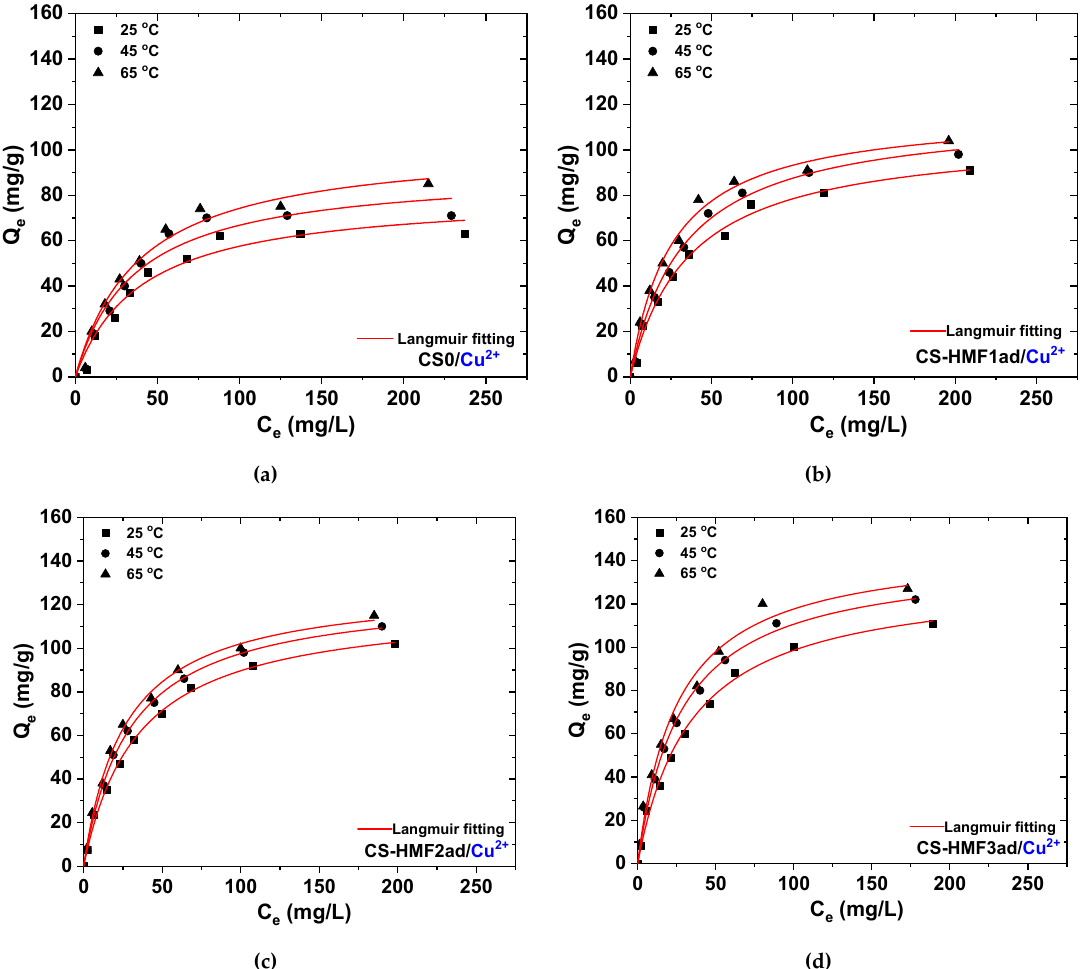
Figure 10. Isotherms for the removal of Cu 2 + : ( a ) CSO; ( b ) CSO-HMF1ad; ( c ) CSO-HMF2ad; ( d ) CSO-HMF3ad. Experimental conditions: C 0 = 10-300 mg / L, V = 20 mL, N = 160 rpm, T = 25, 45, 65 °C, t = 200 min, pH = 5, m = 0.02 g.